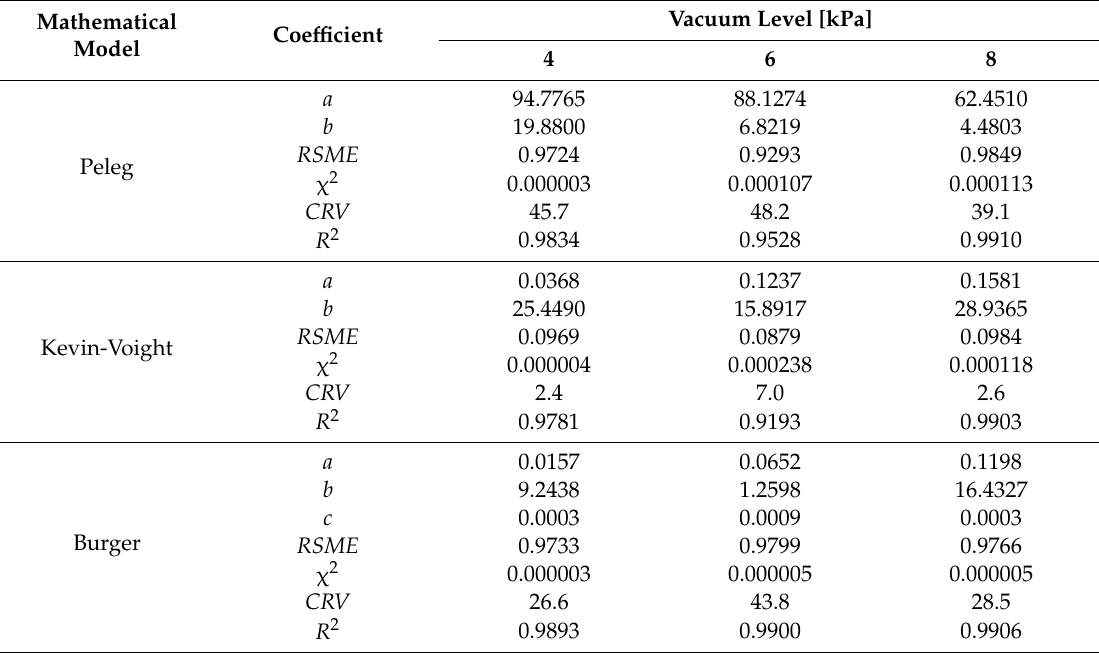
Table 4. Statistical factors in mathematical models fitting the experimental data of SG changes during VI of apples at varied vacuum pressures of 4, 6, and 8 kPa using apple-pear juice as the impregnating liquid. Mathematical